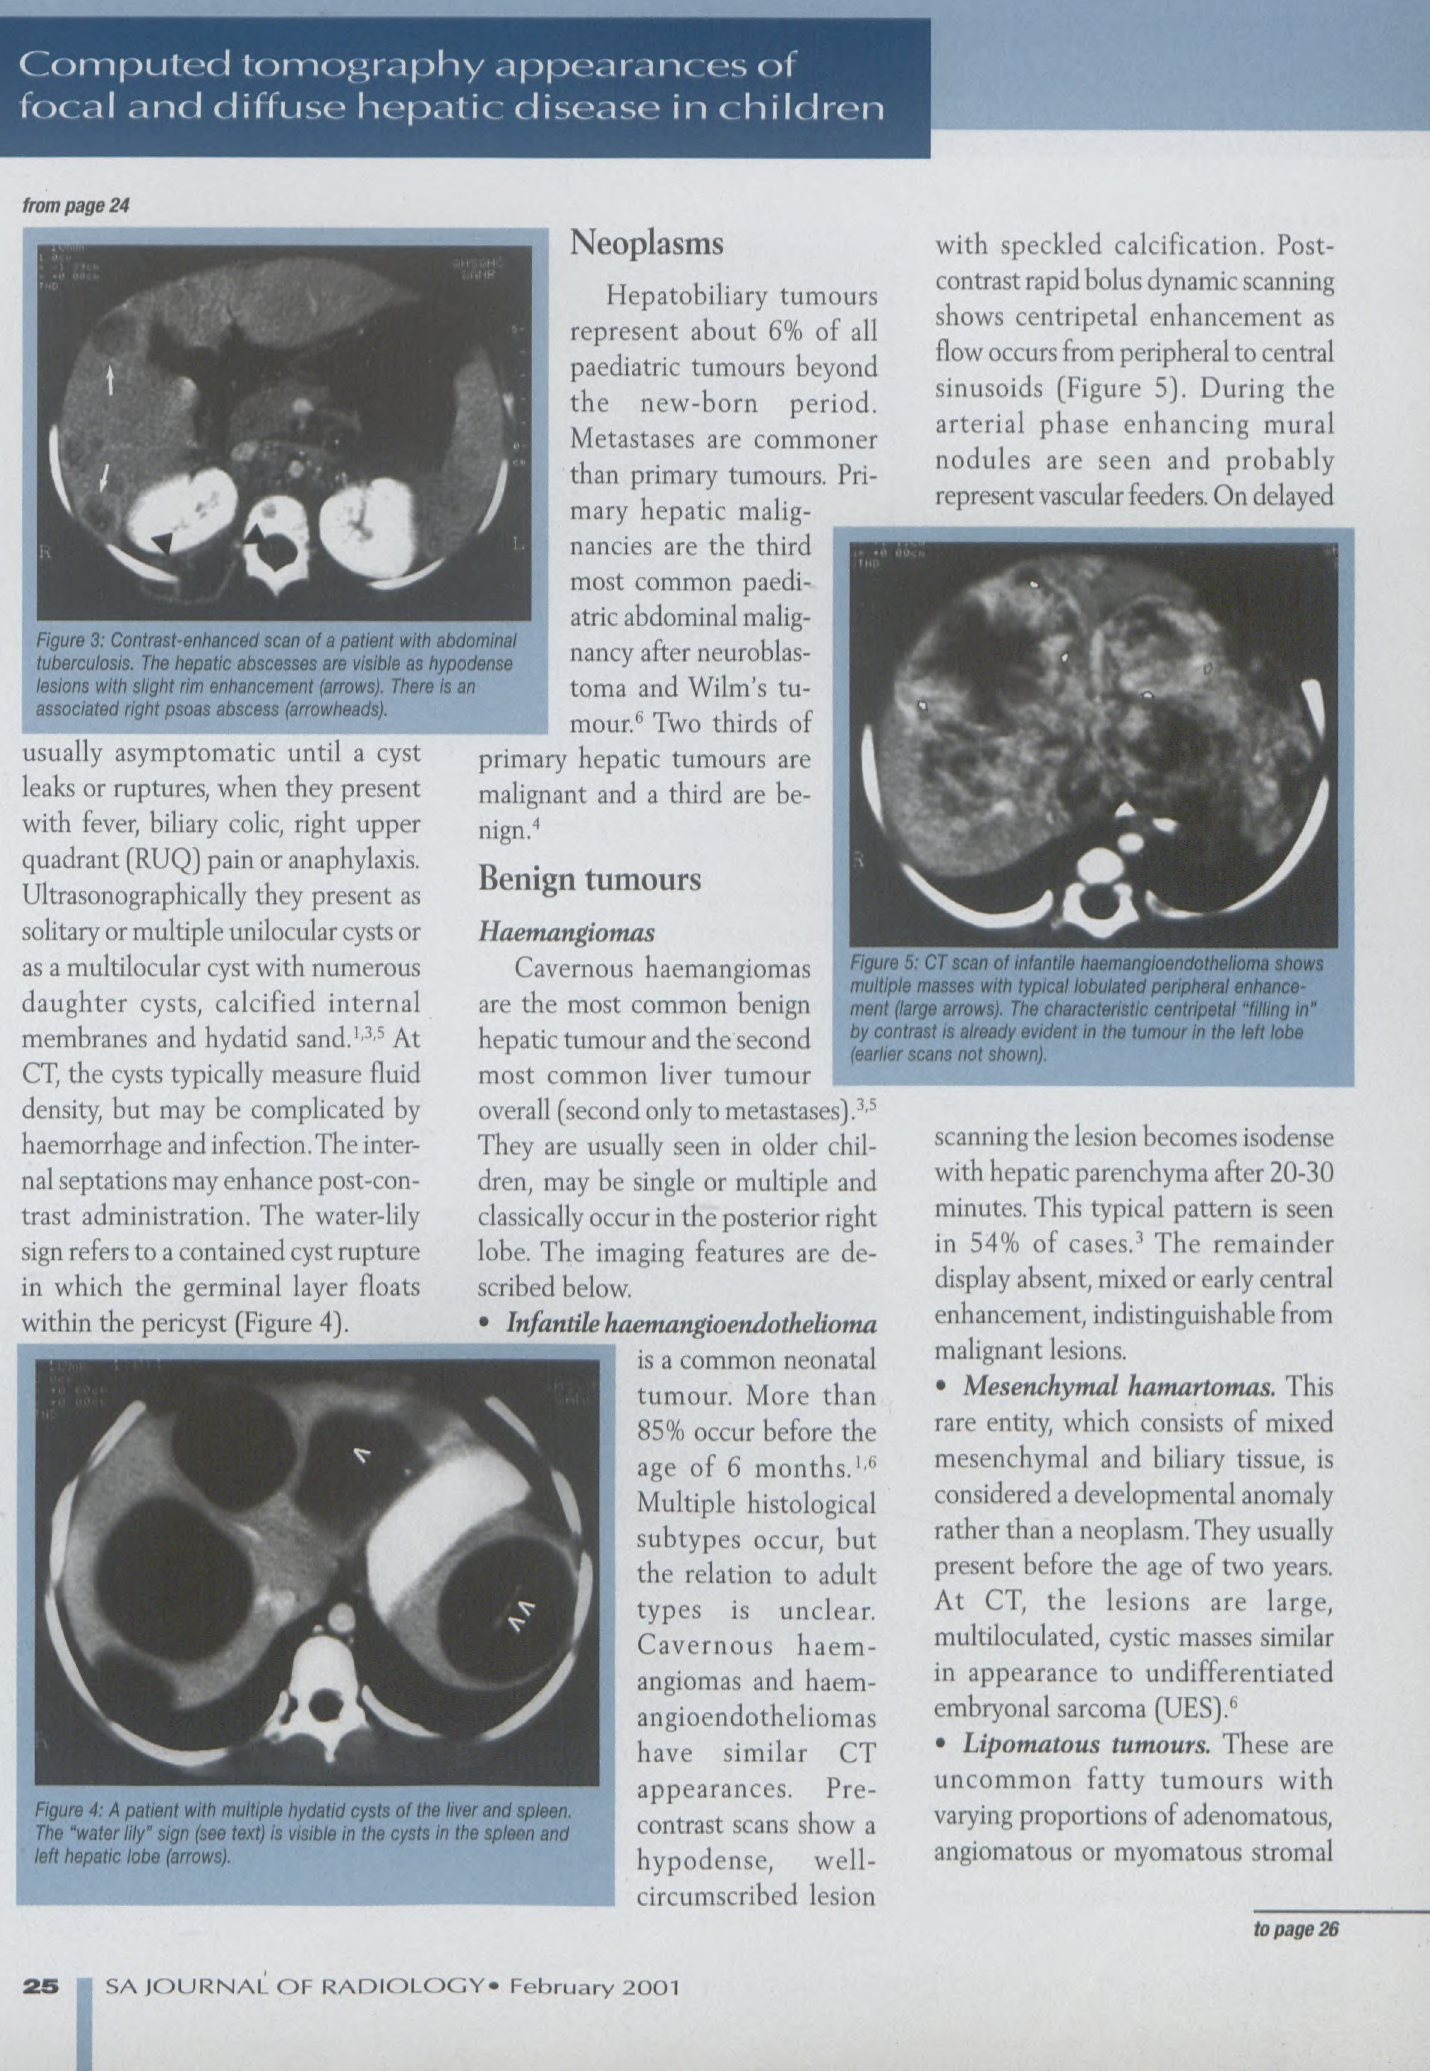
Figure 4: A patient with multiple hydatid cysts of the liver and spleen. The "water lily" sign (see text) is visible In the cysts in the spleen and left hepatic lobe (arrows).